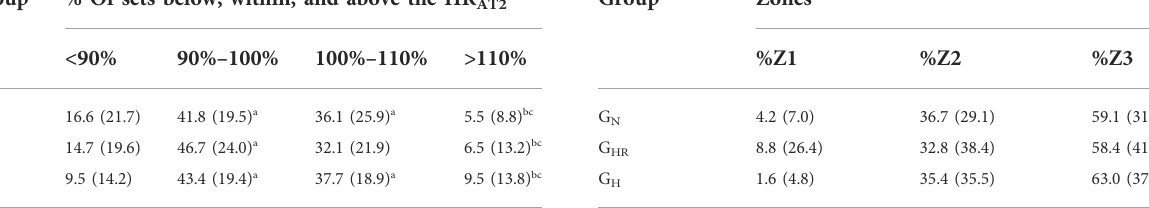
TABLE 3 Comparison of the set percentage below, within, and above the heart rate relative to the anaerobic threshold 2 (HR AT2 ). Group % Of sets below, within, and above the HR